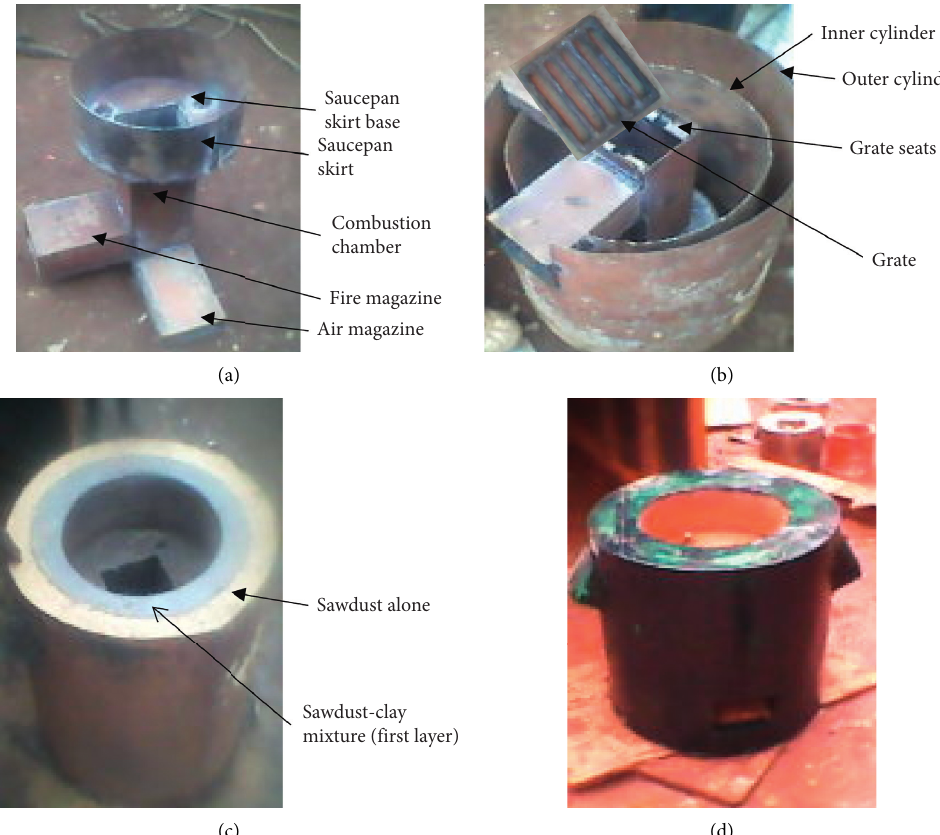
Figure 4: Pictorial synopsis of stove construction: (a) welded key parts, (b) grate and grate seats, (c) casting of the stove with insulations, and (d) painted